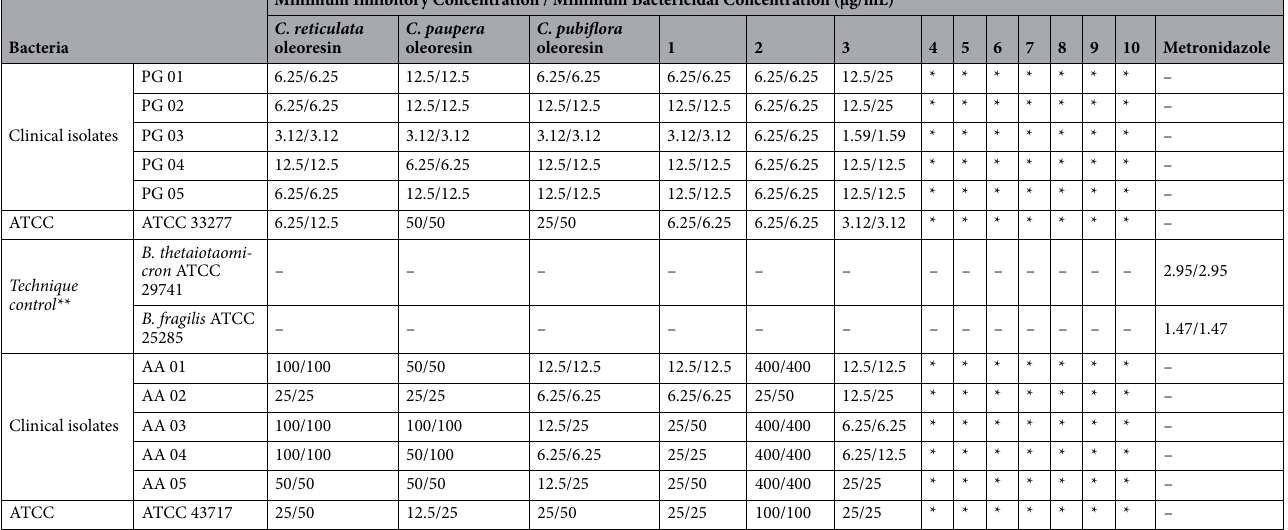
Table 1. Minimum inhibitory concentration and minimum bactericidal concentration of oleoresins and isolated compounds against P. gingivalis and A. actinomycetemcomitans strains. PG Porphyromonas gingivalis, AA Aggregatibacter actinomycetemcomitans. 1 . polyalthic acid; 2 . kaurenoic acid; 3 . hardwickiic acid; 4 . ent -Copalic acid; 5 . isomer [(13E)- ent -labda-7,13-dien-15-oic acid]; 6 . ent -agathic acid; 7. ent -agathic acid 15-methyl ester; 8 . ent - agatholic acid 15-methyl ester; 9 . ent -agatholic acid; 10 . Junenol. *Concentrations considered inactive (> 400 µg/mL).–not tested. **Technique control strains: Bacteroides fragilis (ATCC 25285) and Bacteroides thetaiotaomicron (ATCC